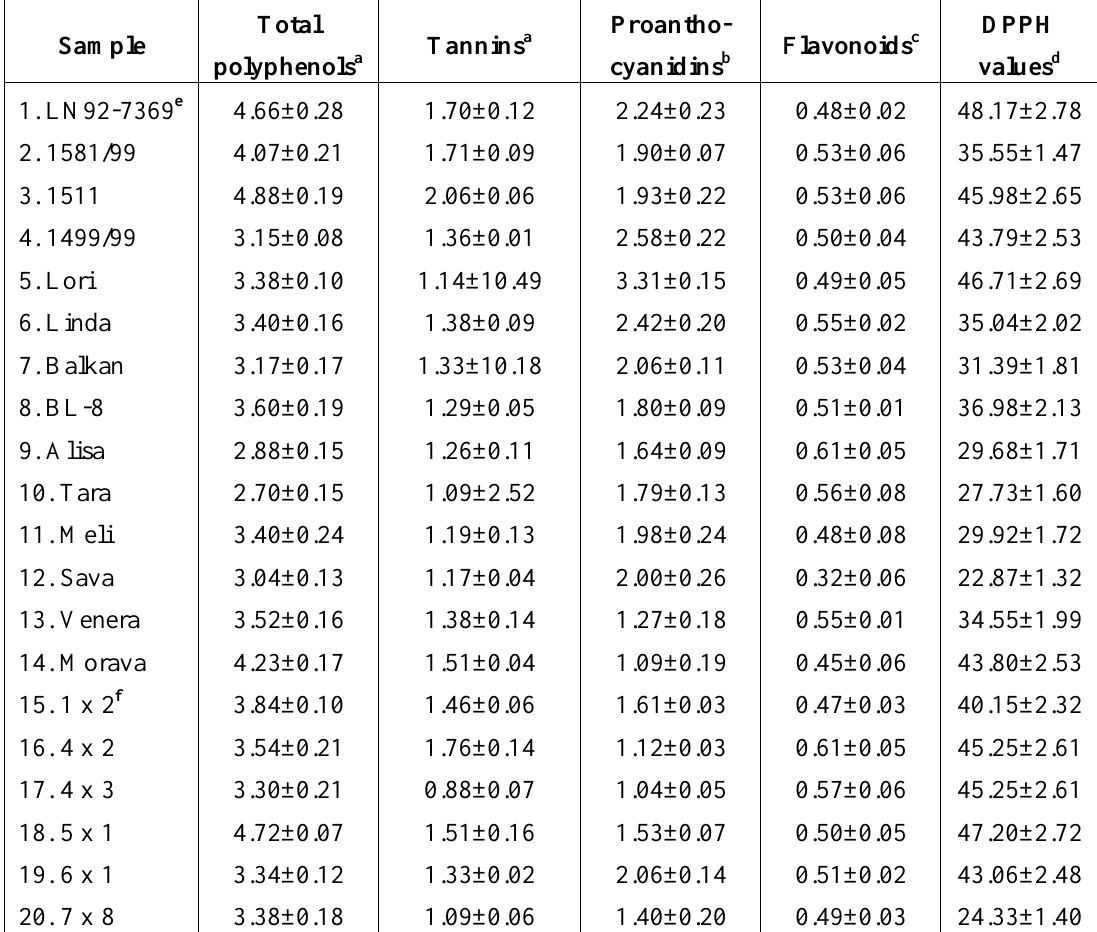
Table 1 . Phenolic contents and antioxidant activity in extracts of investigated soybean